Question: Give a one-sentence summary of this figure.
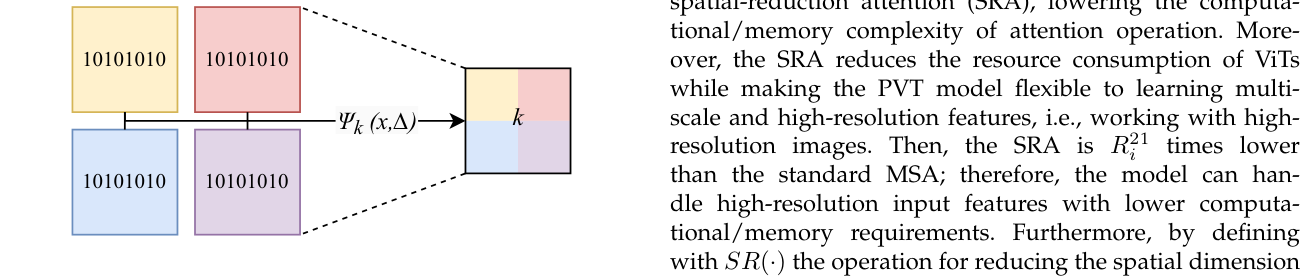
Answer: Graphical representation of a general quantization procedure; the floating-point 32-bit data is compressed based on the quantization function Ψk(x, ∆) to a k-bit representation.